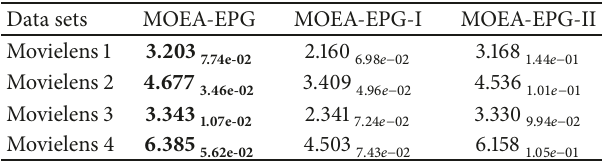
Table 5: HV comparison results of MOEA-EPG, MOEA-EPG-I, and MOEA-EPG-II in the accuracy-coverage space.